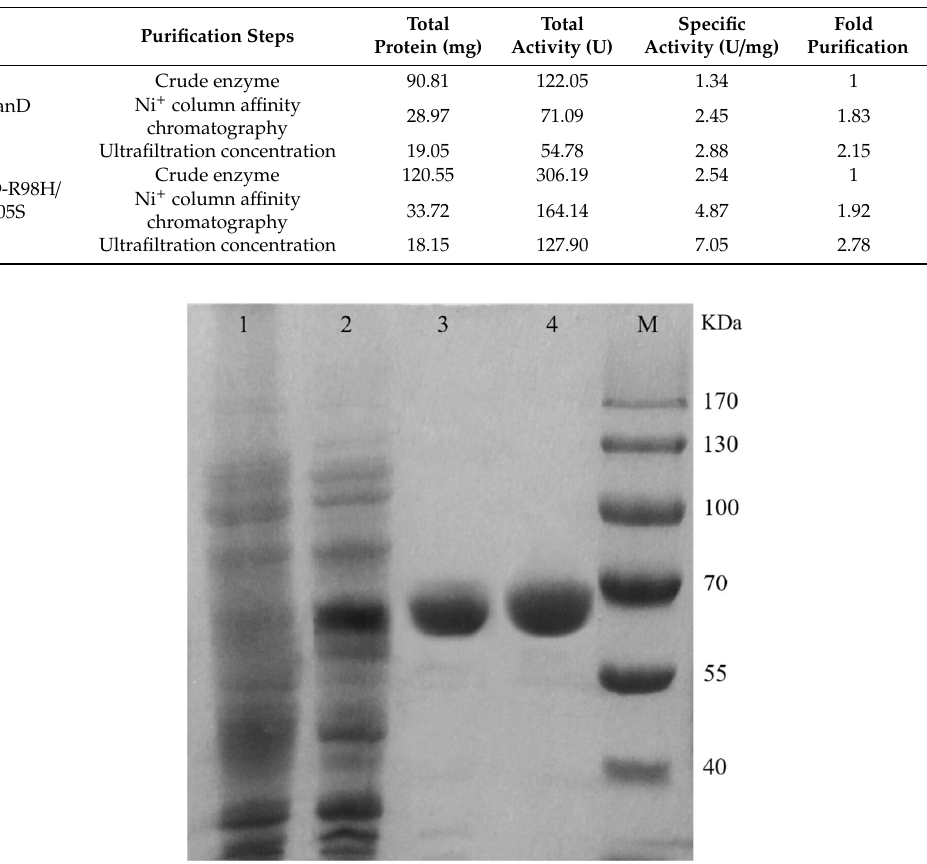
Table 1. Purification table of Tc PanD and Tc PanD-R98H / K305S.